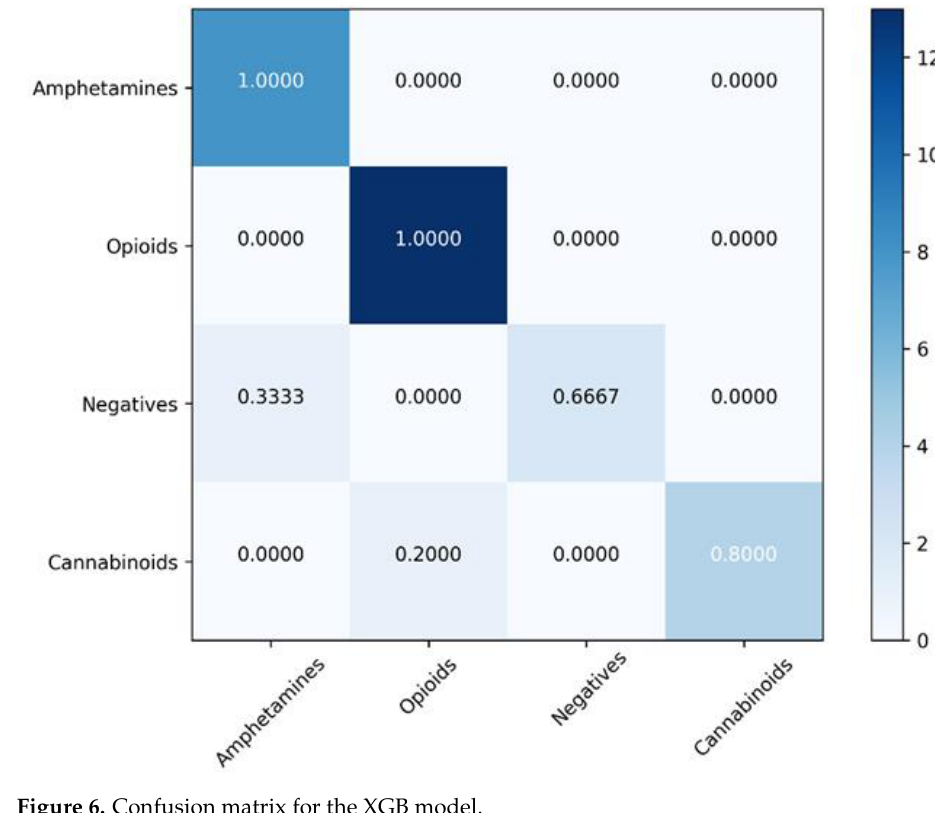
Figure 6. Confusion matrix for the XGB model.